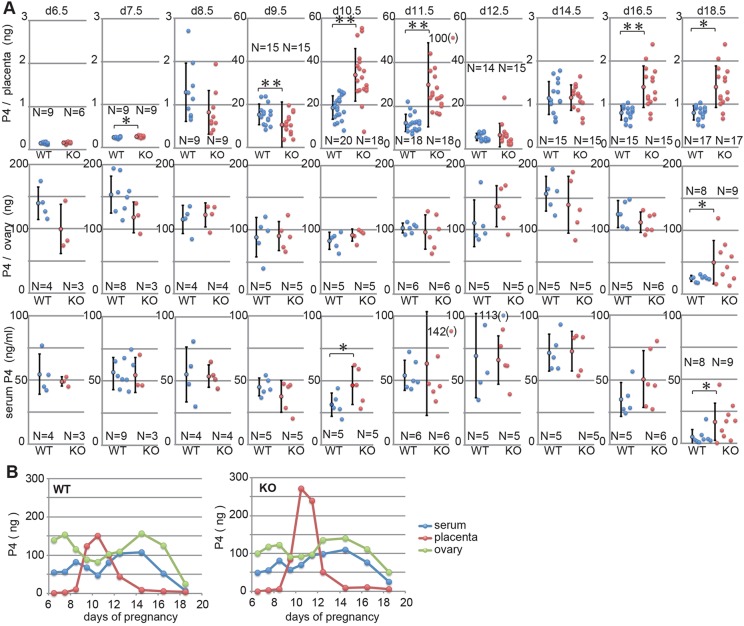
Progesterone levels in the placenta, ovary and serum in wild-type and Sirh7/Ldoc1 KO pregnant females. (A) The amount of P4 in single placenta and two ovaries (both right and left), and the serum P4 concentration of each pregnant +/+ or −/− female (blue and red circles) on d6.5, d7.5, d8.5, d9.5, d10.5, d11.5, d12.5, d14.5, d16.5 and d18.5 are shown (data are mean±s.d., **P<0.01, *P<0.05). Each circle represents the P4 amount or P4 level of a single sample, except ovaries. (B) The average amounts of P4 in the placenta (red) and ovary (green) calculated as eight and two, respectively, and the serum P4 (blue) calculated as 1.5 ml per individual of each pregnant +/+ or −/− female on d6.5 to d18.5 are shown. At least three and six individuals were used for assay before and after d8.5, respectively.